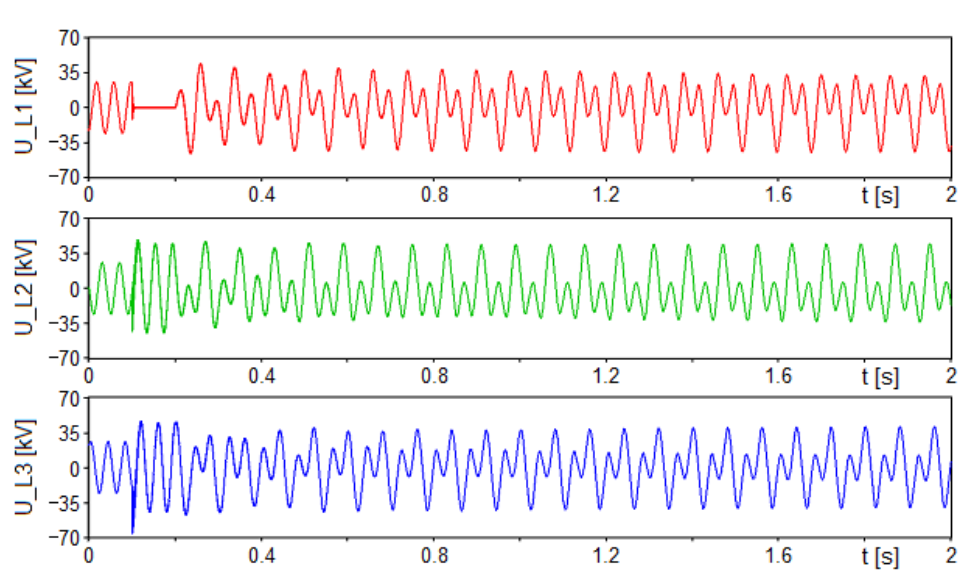
Figure 9. The voltage waveform in the open delta circuit as a result of changing the magnetization characteristics of the voltage transformers from waveform 2 to 1.